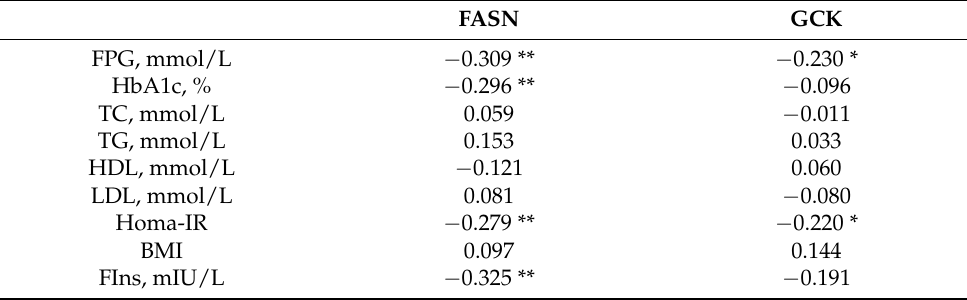
Figure 8. Construction and validation of the hub genes. ( A ) Plots of LASSO regression coefficients versus different values of the penalty parameter. ( B ) Cross − validation plot for the penalty term. ( C ) ROC curves for FGR and FBP1 (AUC: 0.83 and 0.86, respectively); p < 0.05. ( D ) ROC curves for FASN and GCK (AUC: 0.78 and 0.80, respectively); p < 0.05. Table 1. Correlation of FASN and GCK m RNA expression and clinical parameters.